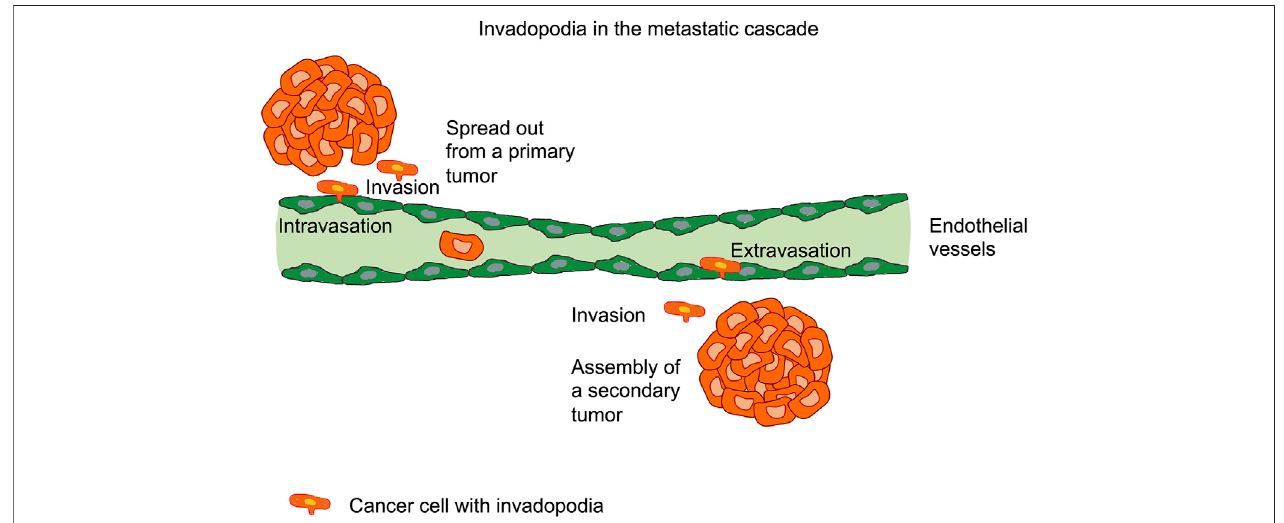
FIGURE1| Cancercellsform invadopodiainmany stepsofthemetastatic cascade, suchasthespreadingoutofcancercellsfromtheprimarytumor,theinvasion through the extracellular matrix tissue environment, the intravasation through the endothelial cell layer into vessels, such as blood or lymphoid vessels, the extravasation ofcancercellsthroughtheendotheliumandsubsequentinvasionthroughtheextracellularmatrixoftargetedtissue.Finally,secondarytumorscanbeassembledandthe metastasis cascade is completed.